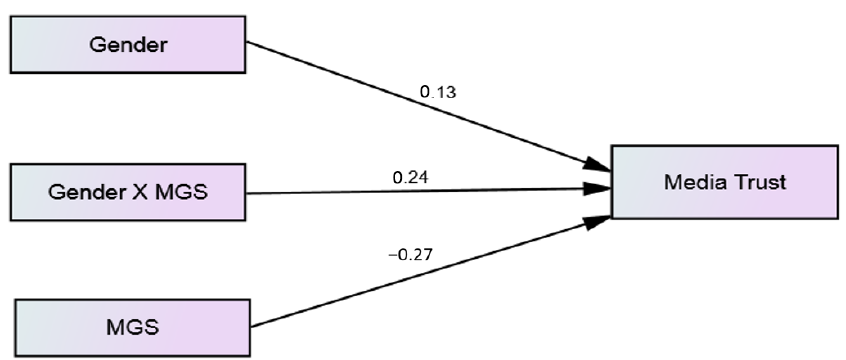
Figure 4. Moderation of Gender in MGS and MT link.